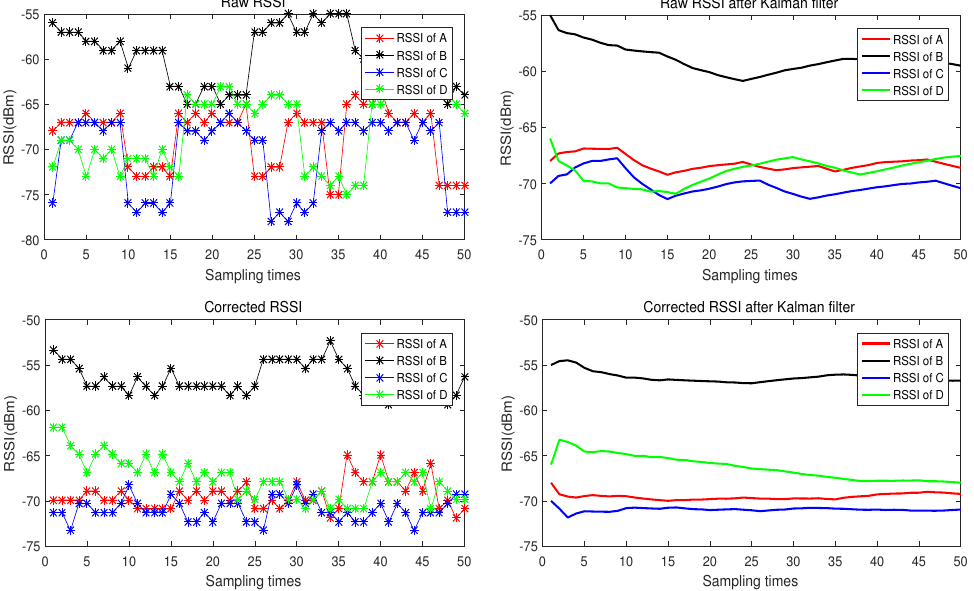
Figure 7. Comparison of the collected RSSI values before and after Kalman